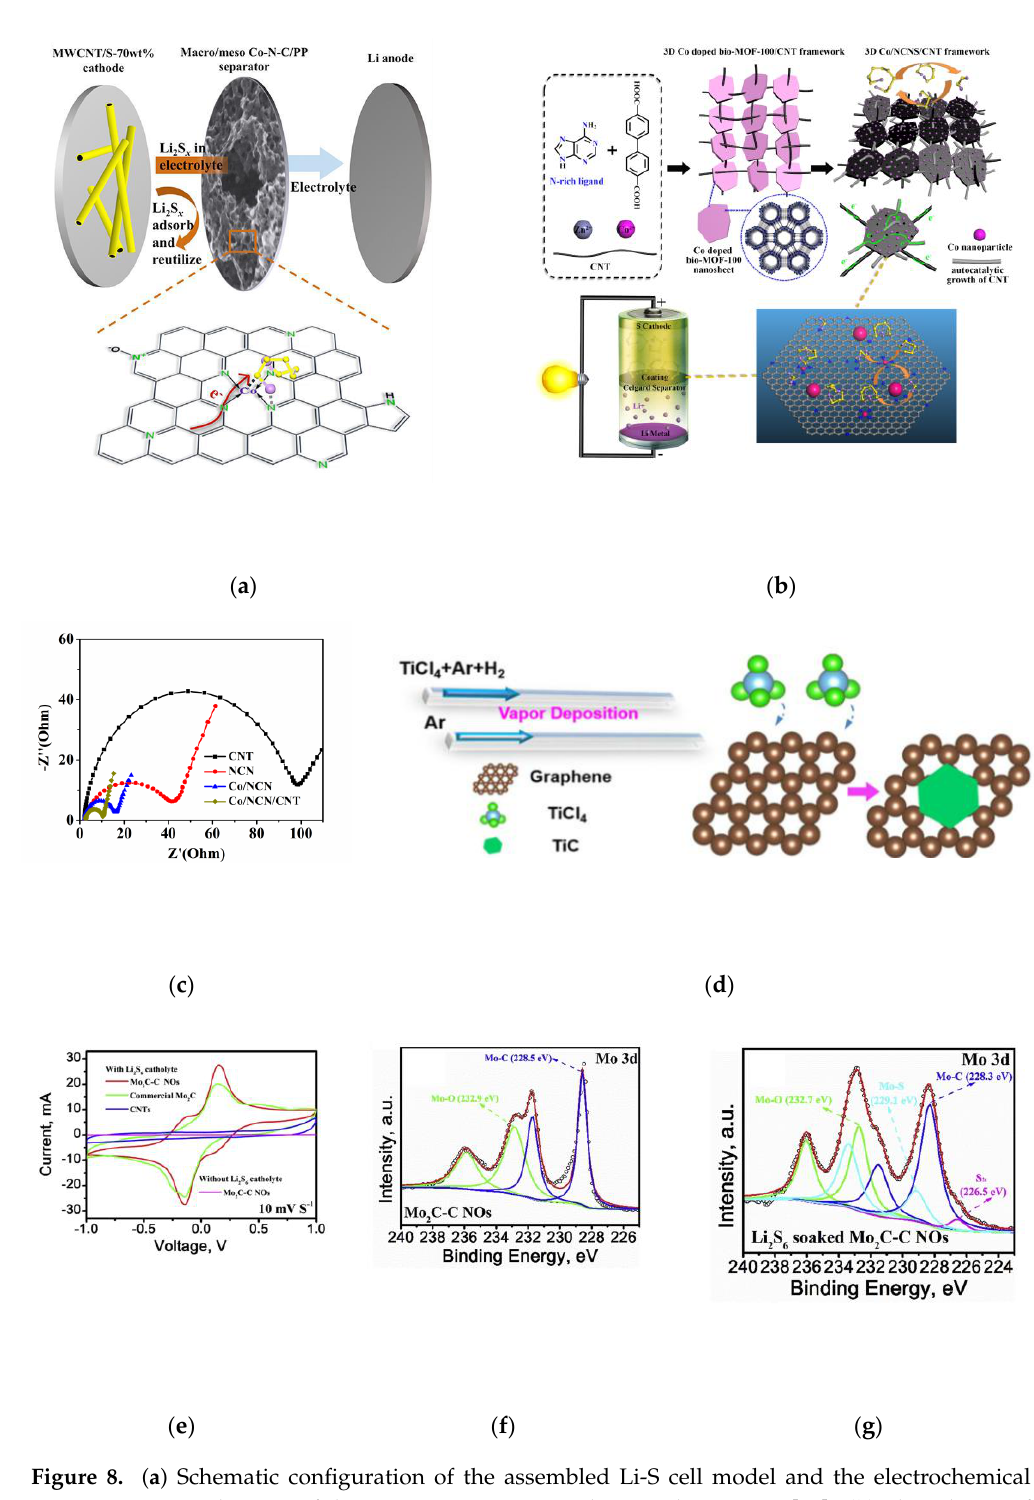
Figure 8. ( a ) Schematic configuration of the assembled Li-S cell model and the electrochemical improvement mechanism of the macro / meso Co-N-C-decorated separator [62]. ( b ) The scheme of improvement mechanism of the macro/meso Co-N-C-decorated separator [62] . ( b ) The scheme of rational rational design of 3D Co / NCNS / CNT as separator coatings for high-performance Li-S battery [63]. design of 3D Co/NCNS/CNT as separator coatings for high-performance Li-S battery [63] . ( c ) The EIS ( c ) The EIS spectra of di ff erent materials in a symmetric cell with Li 2 S 6 in the electrolyte [63]. spectra of different materials in a symmetric cell with Li 2 S 6 in the electrolyte [63] . ( d ) Schematic illustration ( d ) Schematic illustration for the synthesizing TiC nanosheets directly inlaid into the plane of graphene for the synthesizing TiC nanosheets directly inlaid into the plane of graphene templates using TiCl 4 as the templates using TiCl 4 as the reactant [67]. ( e ) The polarization curves of the symmetrical cells with and reactant [67] . ( e ) The polarization curves of the symmetrical cells with and without Li 2 S 6 recorded from without Li 2 S 6 recorded from − 1.0 to 1 V at 10 mVs − 1 [68]. ( f ) Mo 3d spectra of the Mo 2 C–C NOs [68]. −1.0 to 1 V at 10 mVs −1 [68] . ( f ) Mo 3d spectra of the Mo 2 C – C NOs [68] . ( g ) Mo 3d spectra of Li 2 S 6 soaked ( g ) Mo 3d spectra of Li 2 S 6 soaked Mo 2 C–CNOs Mo 2 C – CNOs [68] .